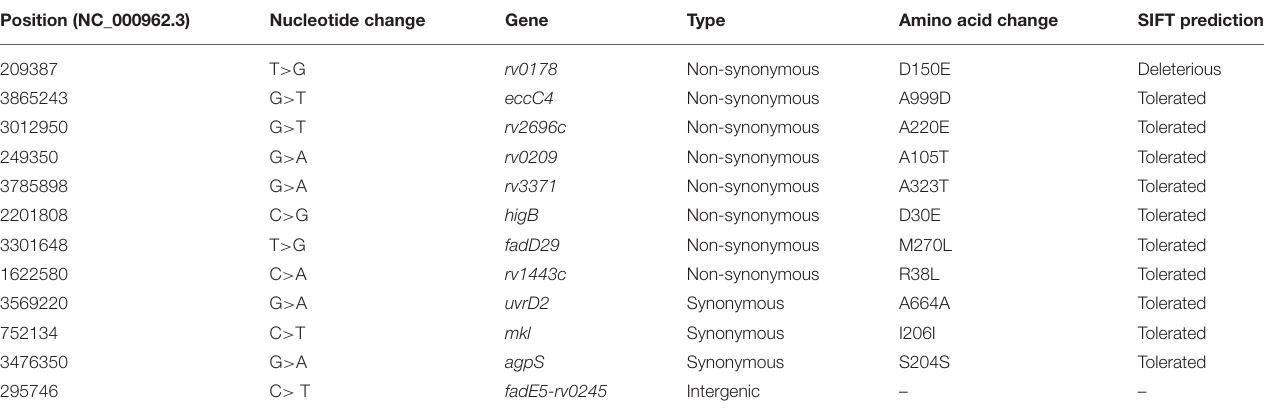
TABLE 2 | Single nucleotide polymorphisms common to H112-clade. Position (NC_000962.3)